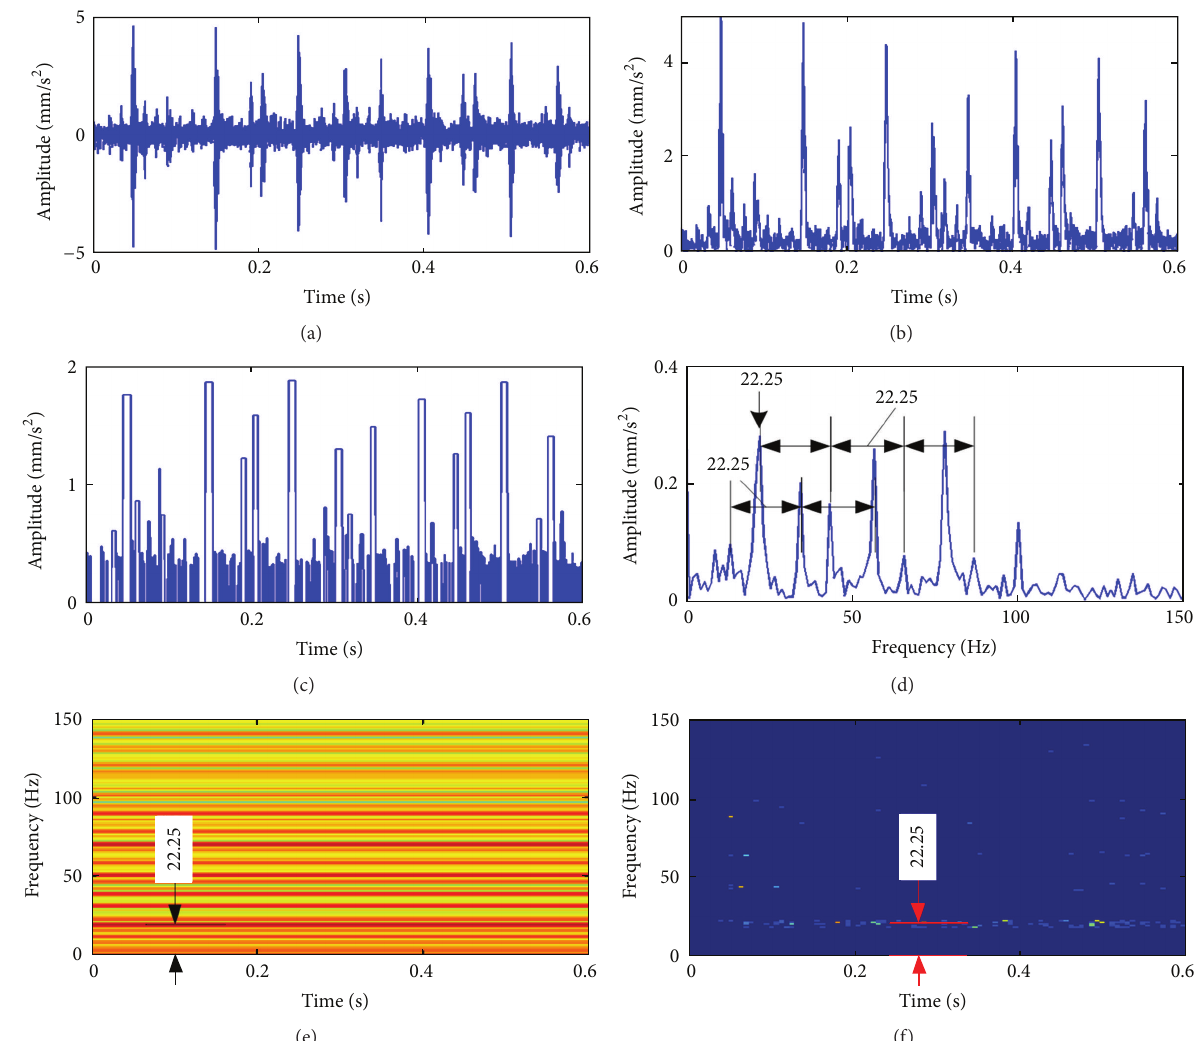
Figure 12: (a) The time domain waveform of the measured data; (b) the time domain waveform of the envelope signal of the measured data; (c) the processing result of the measured data by SPM; (d) The processing result of the measured data by shock pulse frequency spectrum analysis method; (e) the processing result of the measured data by shock pulse time-frequency analysis method; (f) the processing result of the measured data by